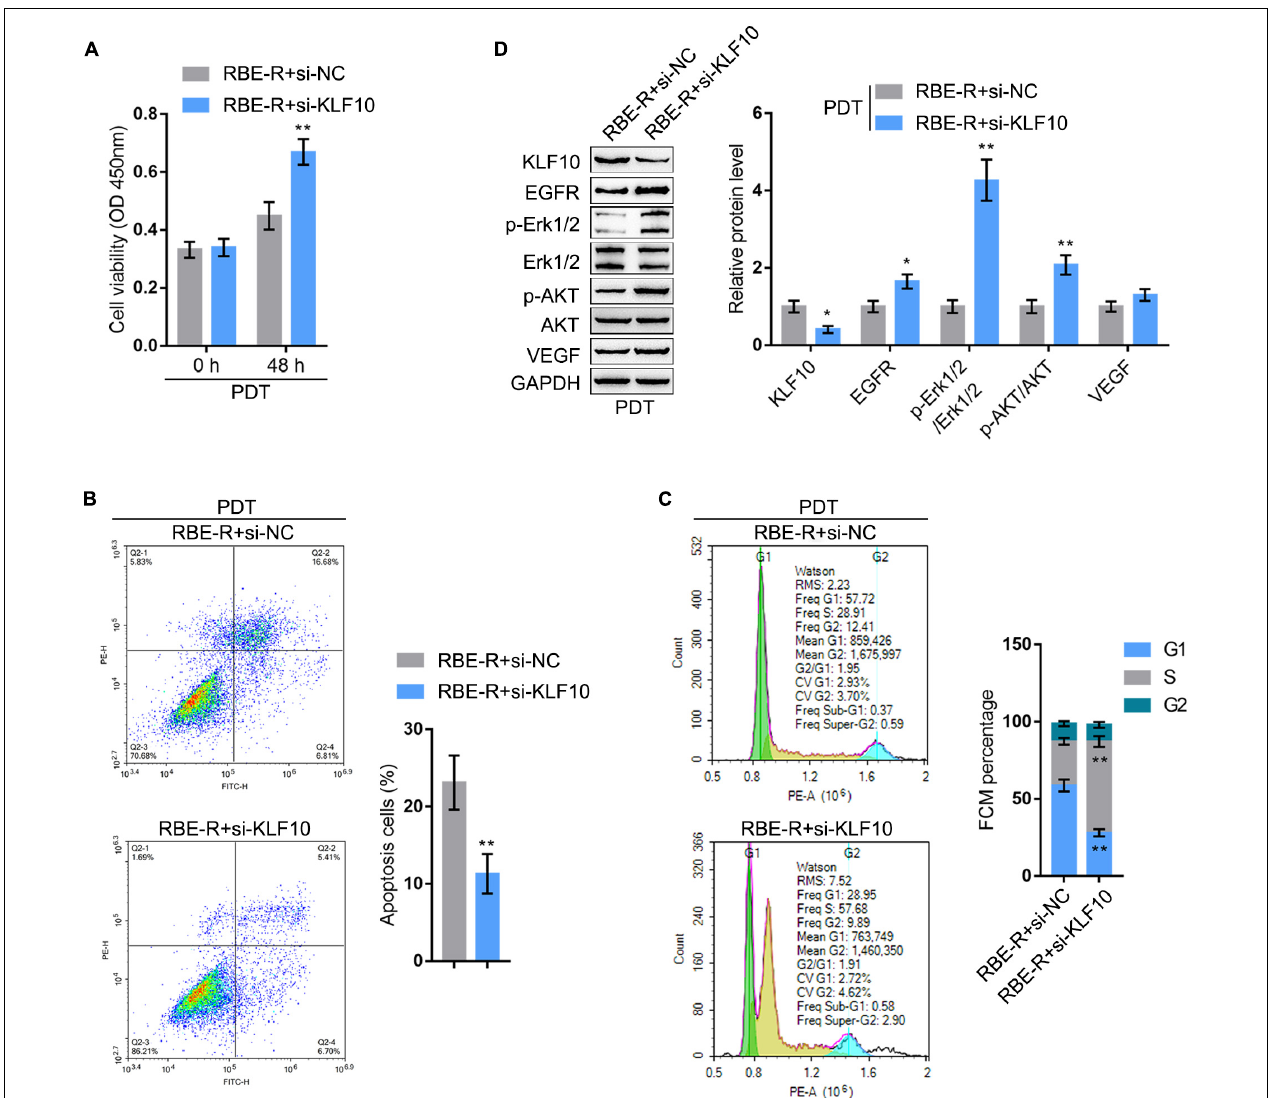
FIGURE 6 | KLF10 silencing attenuates the effects of PDT on gemcitabine-resistant cells. RBE-R cells were transfected with si-KLF10 or si-NC (negative control), exposed to PDT treatment, and examined for the cell viability by MTT assay (A) ; cell apoptosis by Flow cytometry (B) ; cell cycle distribution by Flow cytometry (C) ; the protein levels of KLF10, EGFR, p-Erk1/2, Erk1/2, p-Akt, Akt, and VEGF by Immunoblotting (D) . * P < 0.05, ** P <